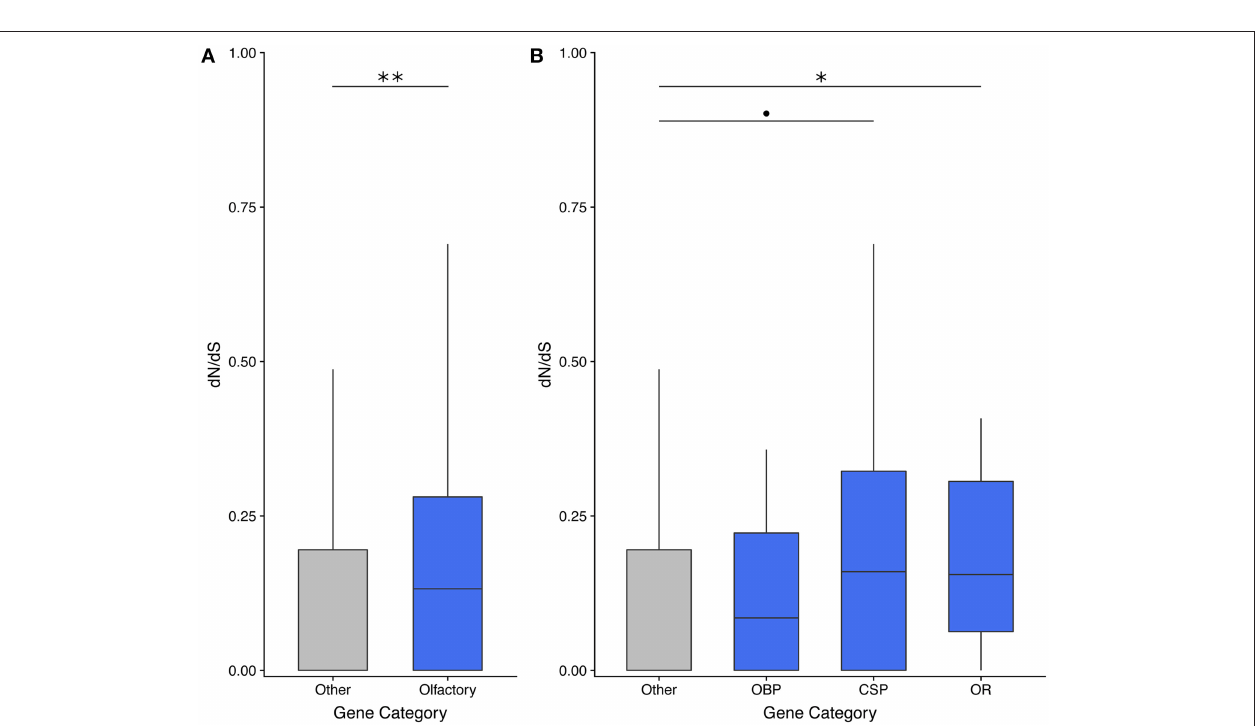
FIGURE 2 | dN/dS analyses reveal that olfactory genes evolve faster than genes with other functions in the asexual species T. monikensis . OBP, odorant binding proteins; CSP, chemosensory proteins; OR, odorant receptors. Codes for levels of significance are 0.01 “**,” 0.05 “*,”0.1 “•” from a Wilcoxon test.